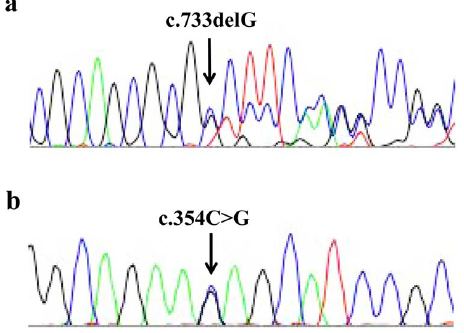
Figure 3. The FOXC2 mutations in spinal extradural arachnoid cyst. a) A heterozygous deletion (c.733delG) in Family 1. b) A heterozygous missense mutation (c.354C . G) in Family 2.